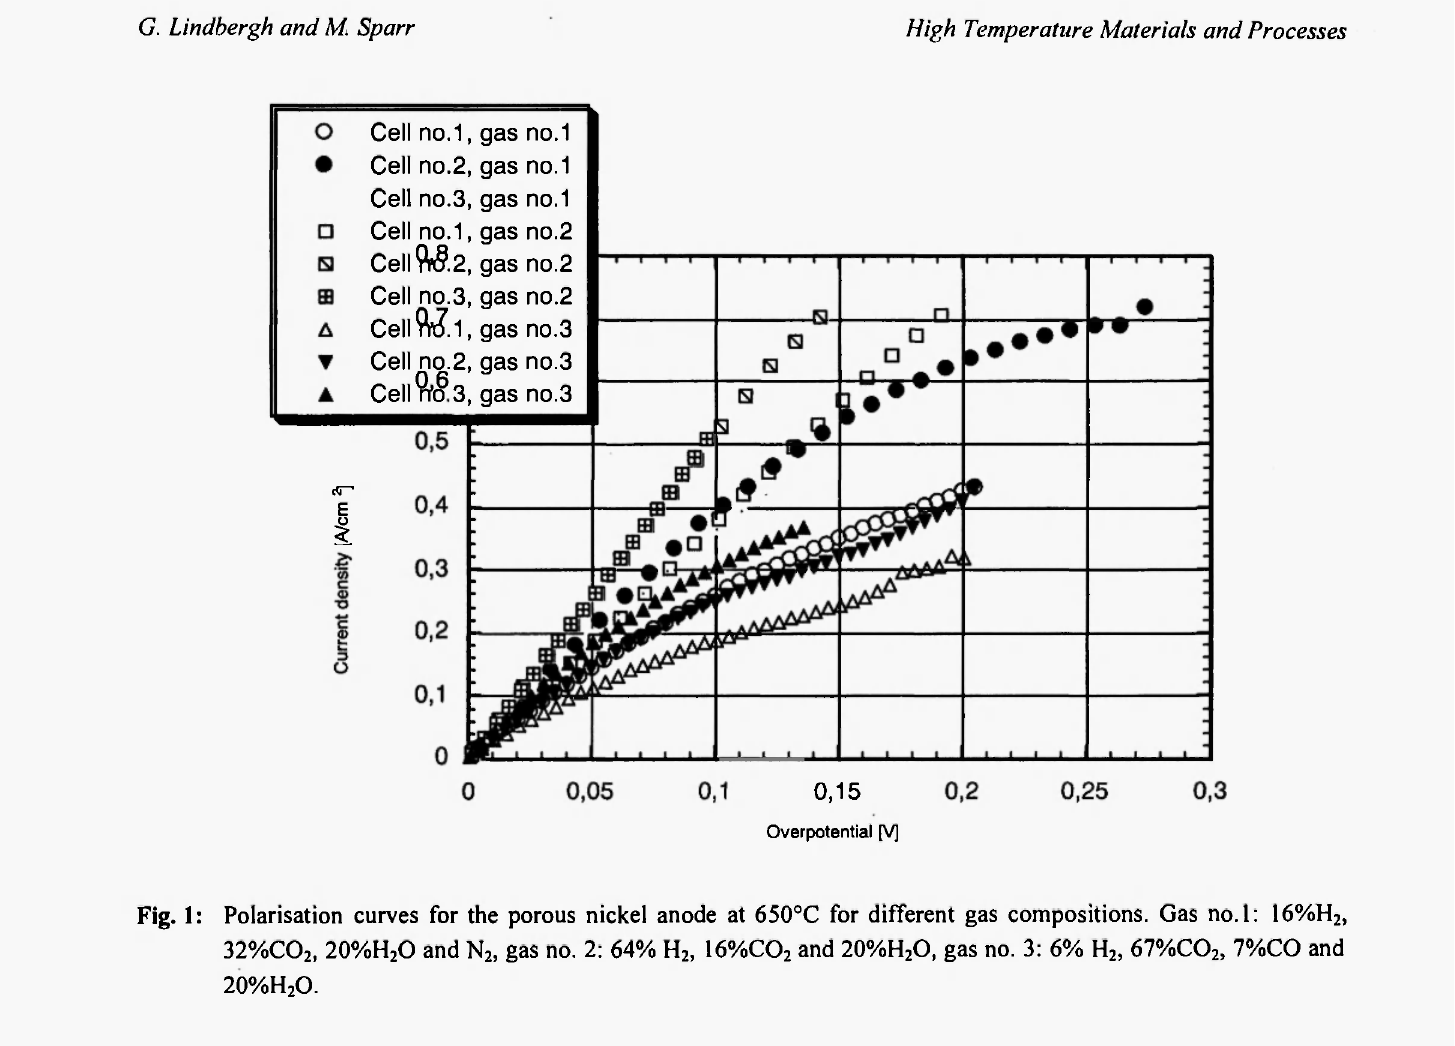
Fig. 1: Polarisation curves for the porous nickel anode at 650°C for different gas compositions. Gas no.1: 16%H 2 , 32%C0 2 , 20%H 2 0 and N 2 , gas no. 2: 64% H 2 , 16%C0 2 and 20%H 2 0, gas no. 3: 6% H 2 , 67%C0 2) 7%CO and 20%H 2